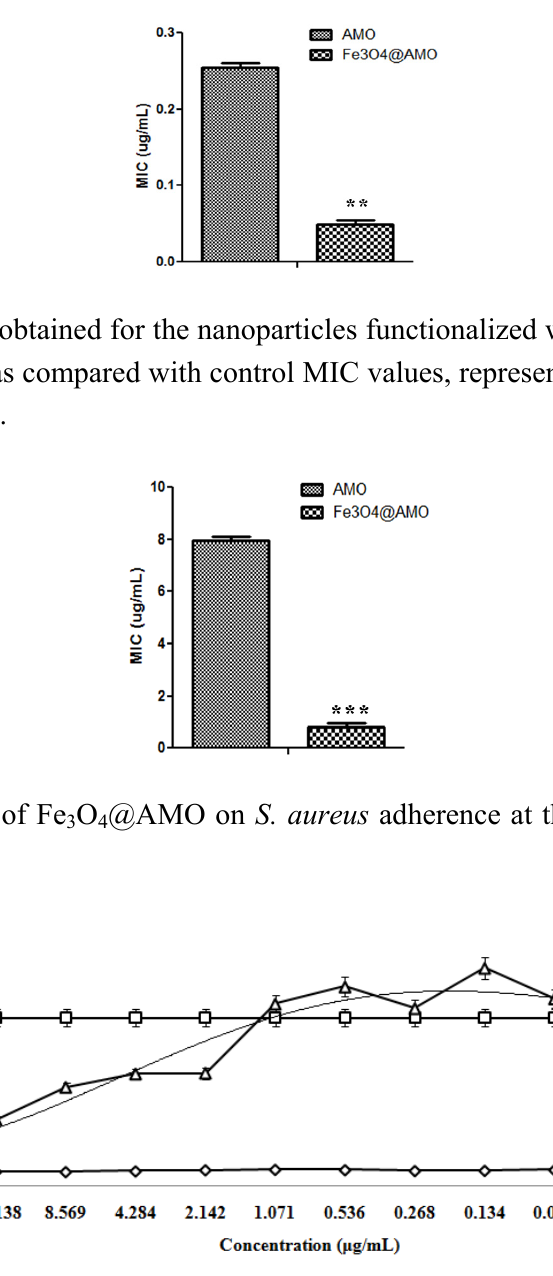
Figure 8. MIC values obtained for the nanoparticles functionalized with antibiotics against S. aureus ATCC 29213, as compared with control MIC values, represented by plain antibiotic solutions, ** p < 0.05.